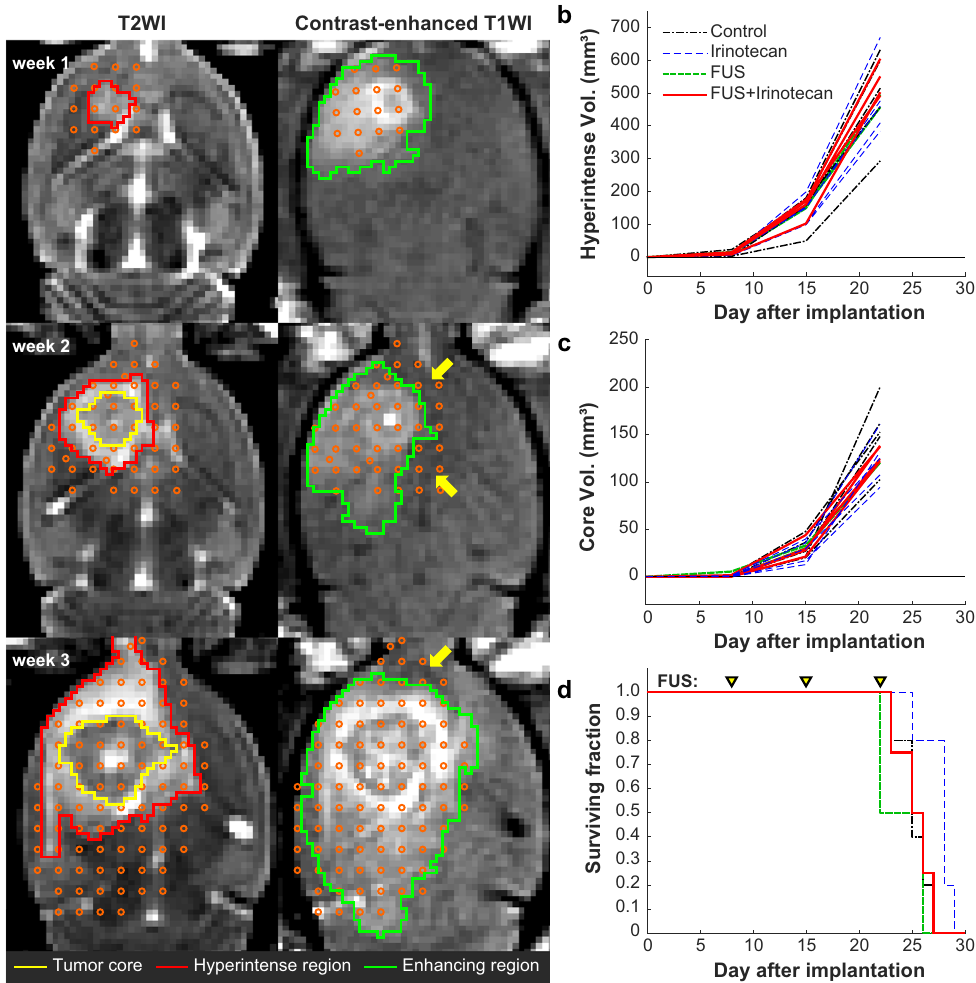
Figure 11. Efficacy study with BBB disruption and IN. (a) T2-weighted MRI (T2WI) and contrast-enhanced T1-weighted MRI (T1WI) of an F98 glioma over three weeks. Sonication targets were planned to cover the extent of the tumor core (yellow contours) as well as the hyperintense areas (red contours) evident in T2-weighted imaging. The plan included hyperintense areas evident in other planes. The resulting contrast enhanced area covered most of the planned region in most cases. Areas that were not enhancing in the central plane (arrows) were enhancing in other planes. ( b , c ) Tumor volume vs. time for animals that received drug only, BBB disruption only, drug and BBB disruption, or no treatment. No significant difference was observed among the groups in the volume of the hyperintense areas ( b ) or in the central core of the tumor ( c ). ( d ) Kaplan-Meier survival plots. No significant difference among treatment groups was